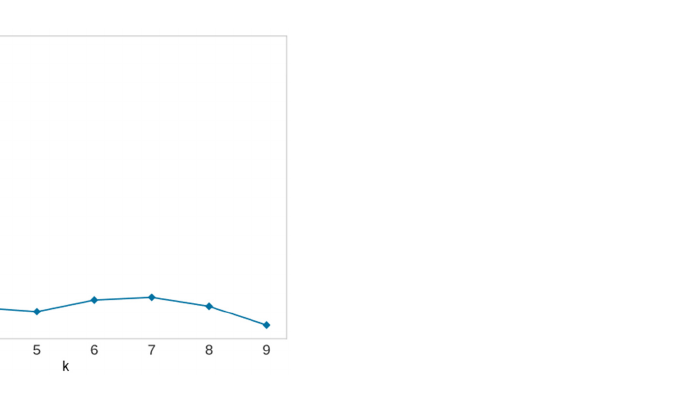
10 Figure 6. Theoptimal numbers of clusters calculated with the elbow method. 3.2.2. Silhouette Method Figure 7 depicts a plot of the SC value versus the number of clusters for biochemical